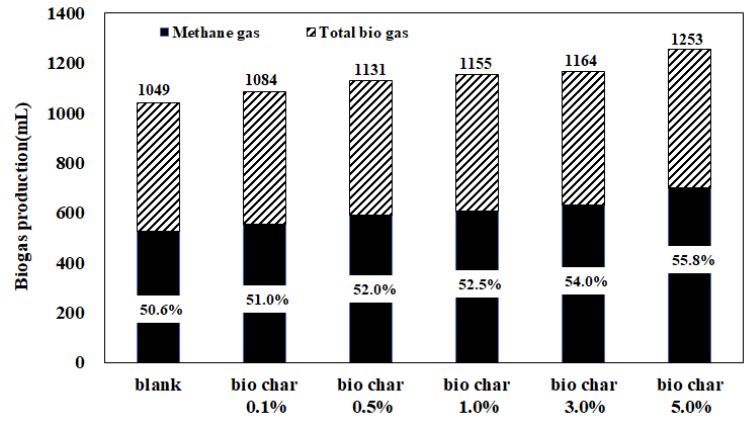
Figure 3. Comparison of total gas generation and methane content with biochar content.